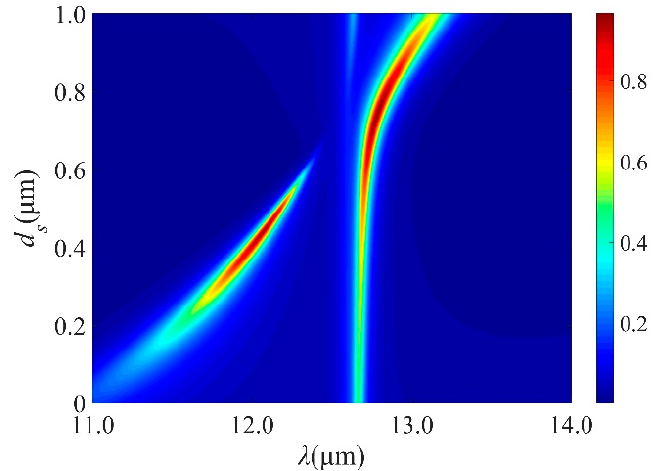
Figure 3. Emission spectra of the design with different d s under normal incidence for TM polarization with 5 DBR pairs when t = 0.45 μ m, d 1 = 1.25 μ m and d 2 = 0.75 μ m. To check the tunability of the resonance, effects of structural parameters on the emis- sion spectrum is evaluated. Perfect absorption can be achieved by optimizing t , d 1 and d 2 . The absorption will be influenced by t , and the resonance emission red-shifts when t varies from 0.3 μ m through 0.6 μ m, as seen from Figure 4a. The maximum peak absorptance decreases with increasing t . The optimal value of t is chosen as 0.45 μ m. As seen from Figure 4b, the absorptance band presents a red-shift as d 1 increases. Moreover, the reso- nance emission meets a splitting with increasing d 2 , as depicted in Figure 4c. The position and intensity of the absorption peak can be adjusted with the changing of the incident angle, which is extremely important for MIR emission. Figure 5a,b show the relationship between the emission spectra and the incident angle under TE and TM polarizations. As on can see in Figure 5a, when incident angle varies from 0° to 40°, the absorption intensity is very stable with a narrowing bandwidth. The absorption intensity reduces rapidly with the incident angle over 60°. The emission spectra under TM polarization is illustrated in Figure 5b. Intuitively, a flat and near-perfect absorption band appears in the vicinity of 12.8 μ m. In order to better understand the response, Figure 5c,d describe the angular distribution of thermal emission of the structure at different wavelength. It is shown that a wide emission in the normal direction and the angular width can reach 50°.